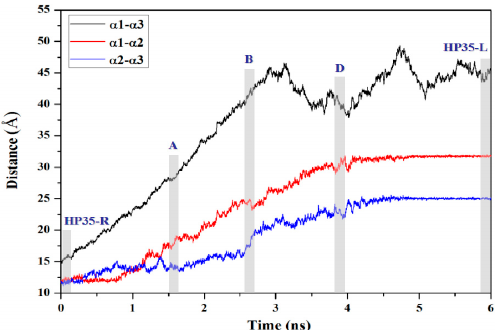
Figure 8. Mass center distances between α 1 and α 3 helices (black),between α 1 and α 2 helices (red), and between α 2 and α 3 helices (blue) along the transition pathway from the simulation of HP35-R to HP35-L; the mazarine letters in the grey areas denote HP35-R, A, B, C, D and HP35-L conformations.